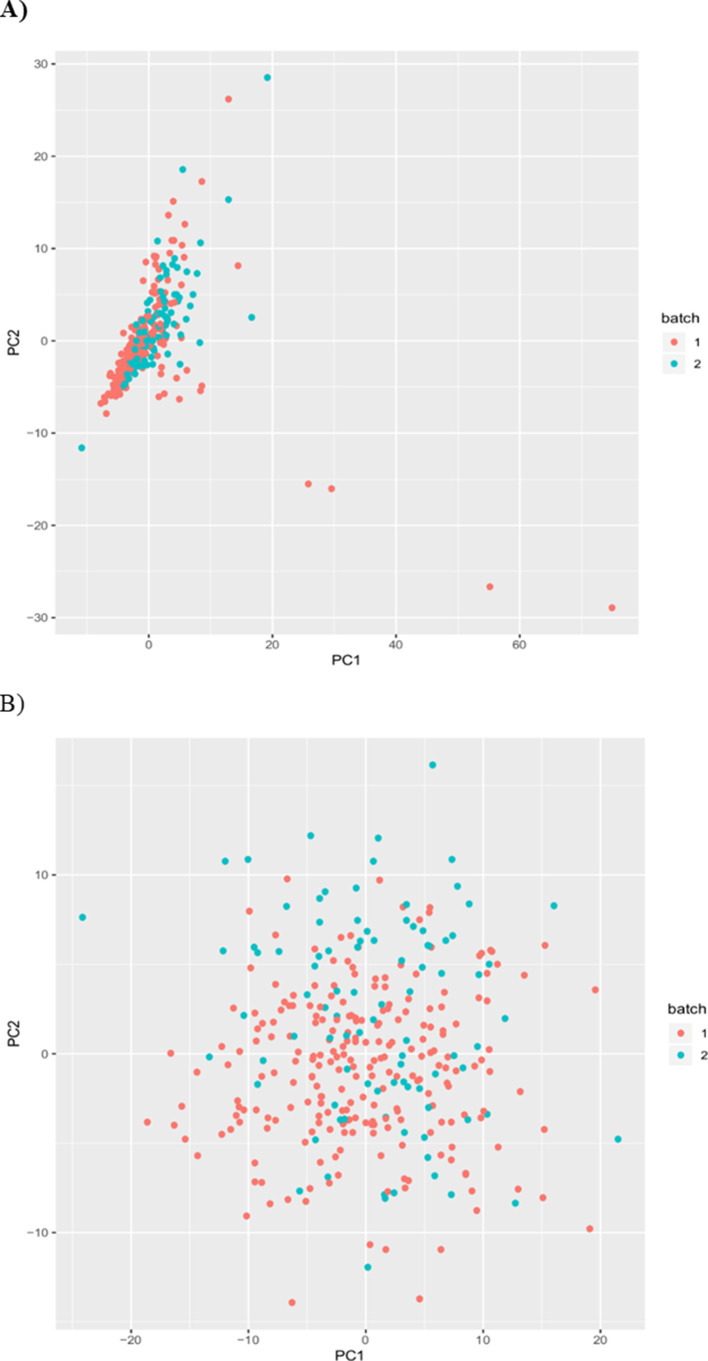
Batch correction using inverse rank normal transform of residuals.PCA plots showing good overlap of experimental batch lipids after (A) residuals were taken and (B) after inverse rank normal transformation was applied to these residuals.